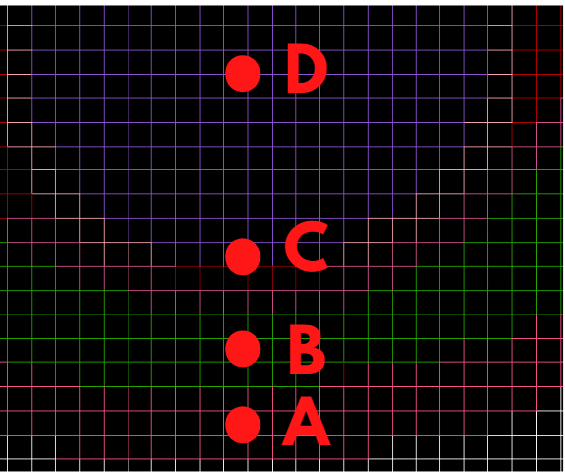
Figure 3. The 4 test points located in the layers of the eye for the reference model. Eyelid (A), muscle (B), lens (C), and eye vitreous (D).